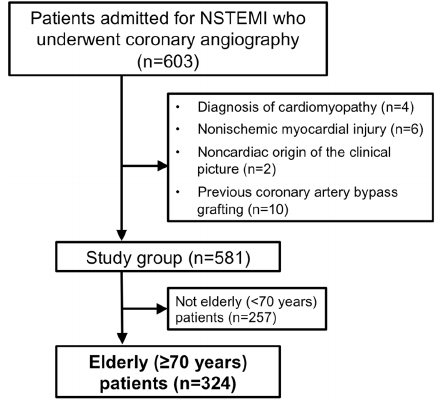
Figure 1. Flowchart of patients included in the